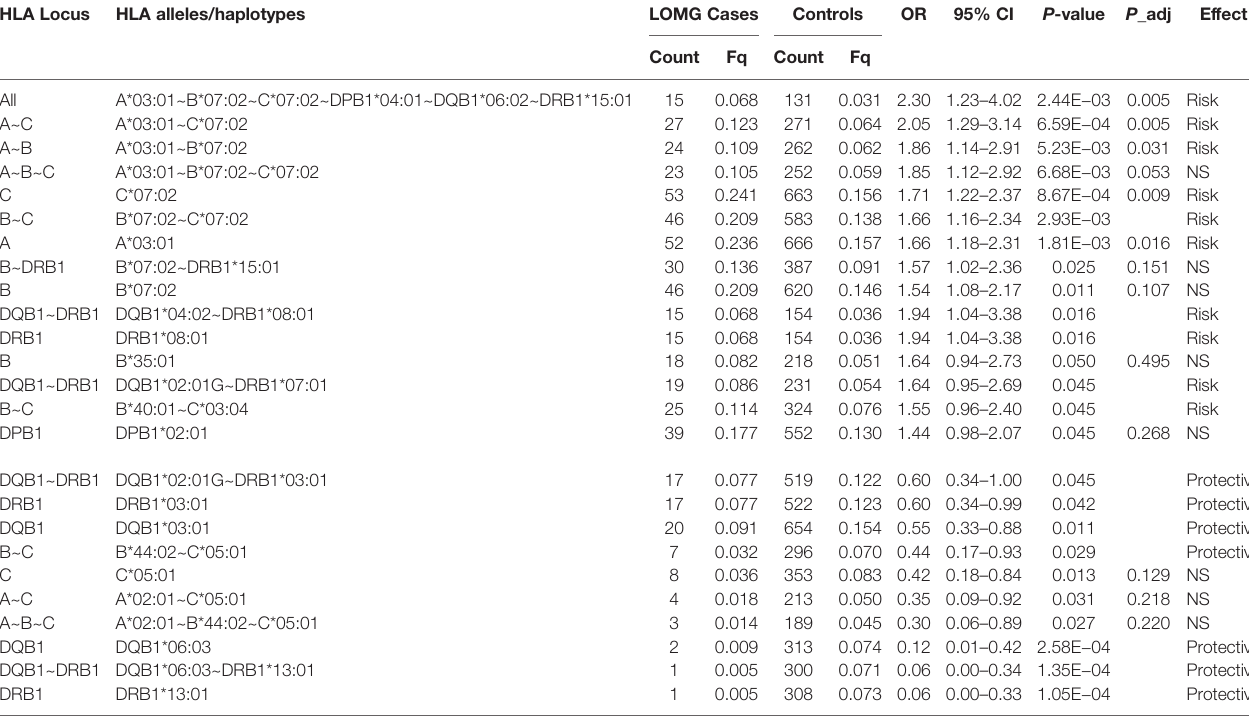
LOMG, late-onset Myasthenia Gravis; Fq, frequency; OR,odds ratio; CI, con fi dence interval; P_adj, Bonferronicorrected P-values, P-values forHLA-B~C, HLA-DQB1~HLA-DRB1, HLA- DRB1, and HLA-DQB1 alleles were not corrected for multiple comparisons; Effect, effect of allele/haplotype on disease outcome. NS, not signi fi